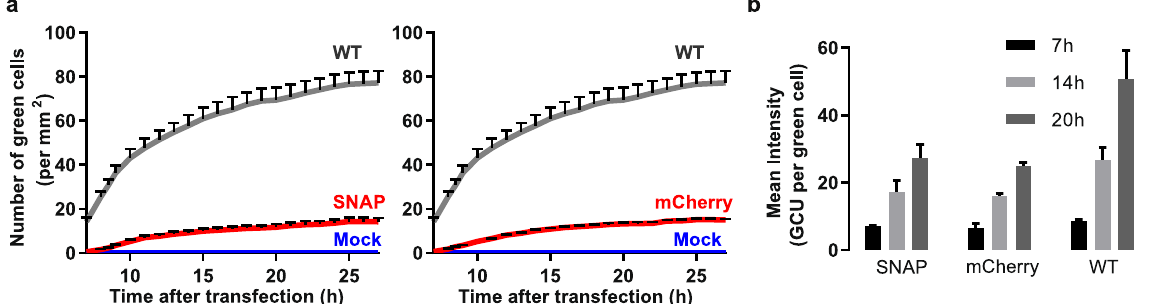
Figure 3. SNAP-tagged replicon retains replicative capacity. ( a ) Subgenomic RNA in HuH-7 cells transfected with CHIKV SNAP-P3 sg-ZsGreen (SNAP), CHIKV mCherry-P3 sg-ZsGreen (mCherry), and CHIKV repl sg-ZsGreen (WT) replicons was quantified by measuring the level of ZsGreen protein. The level of green fluorescence was monitored hourly by live-cell imaging with an IncuCyte ZOOM instrument equipped with a 10 × objective. Mean values are plotted alongside standard error of measurement (SEM) from three independent transfections, with nine images taken at indicated times for each replicate (7 h to 27 h after transfection). Data are presented as the number of green objects (cells) per mm 2 . Untransfected cells, which remained non-fluorescent, were included as a negative control (Mock). ( b ) Mean values of the fluorescence intensity in the green channel were calculated (in GCU, green calibrated units, per cell) with the instrument’s software. Averages at three time-points (7 h, 14 h, and 20 h after transfection) are plotted alongside standard error of measurement (SEM) from three independent